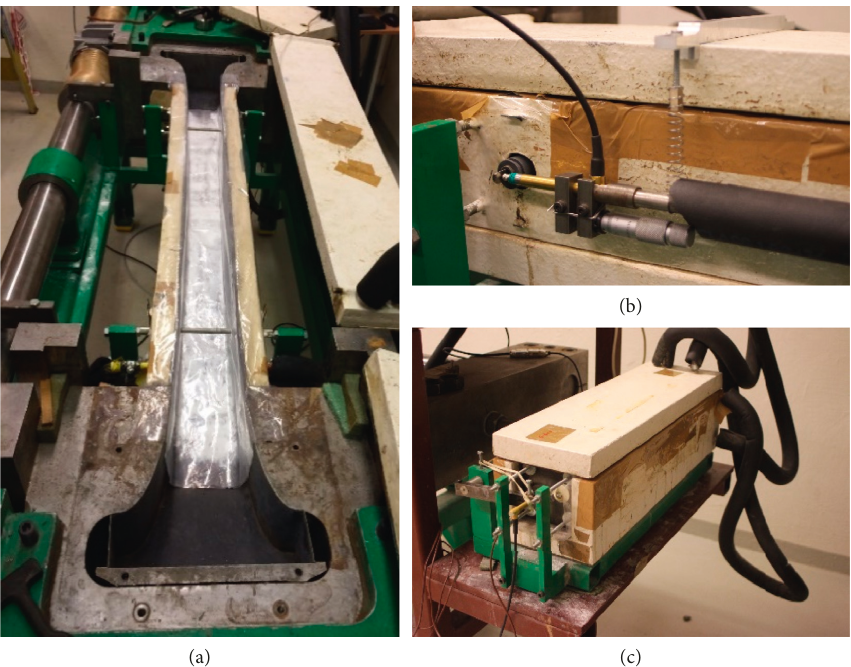
Figure 1: The TSTM system: the dog-bone form in the TSTM (a), the TSTM LVDT set-up (b), and the dilation rig